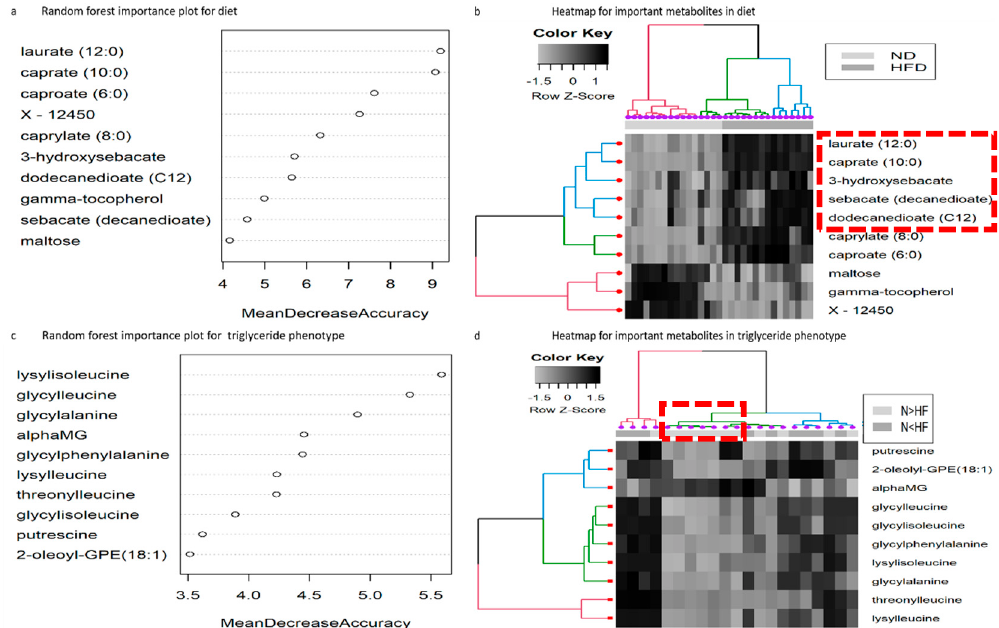
Figure 1. ( a ) Metabolite importance (top 10) calculated by Mean Decrease Accuracy for classification between a high-fat diet and normal diet. ntree = 1000, mtry = 18, OOB error rate = 3.23%, class error rate: high-fat diet = 0.0, normal diet = 0.06. ( b ) Heat map showing hierarchical clustering using Ward’s algorithm for the top 10 important metabolites identified by random forest for high-fat and normal diet. The clustering is done by sample (dark grey = high-fat, light grey=normal, along x -axis) as well as by metabolites (along y -axis). The red, green, and blue colors indicate the three distinct clusters identified. The red box indicates metabolites potentially involved in omega-fatty acid oxidation ( c ) Metabolite importance (top 10) calculated by Mean Decrease Accuracy for classification between reaction norm phenotypes ( N > HF ) and ( N < HF ). ntree = 1000, mtry = 18, OOB error rate = 23.81%, class error rate: N > HF = 0.33, N < HF = 0.16. ( d ) Heat map showing hierarchical clustering using Ward’s algorithm for the top 10 important metabolites identified by random forest for reaction norm phenotypes: The clustering is done by sample (dark grey = N < HF , light grey = N > HF , along x -axis) as well as by metabolites (along y -axis). The red, green, and blue colors indicate the three distinct clusters identified. The red box indicates three genotypes corresponding to N < HF phenotype exhibiting the same concentration profile for dipeptides irrespective of being on high-fat or normal